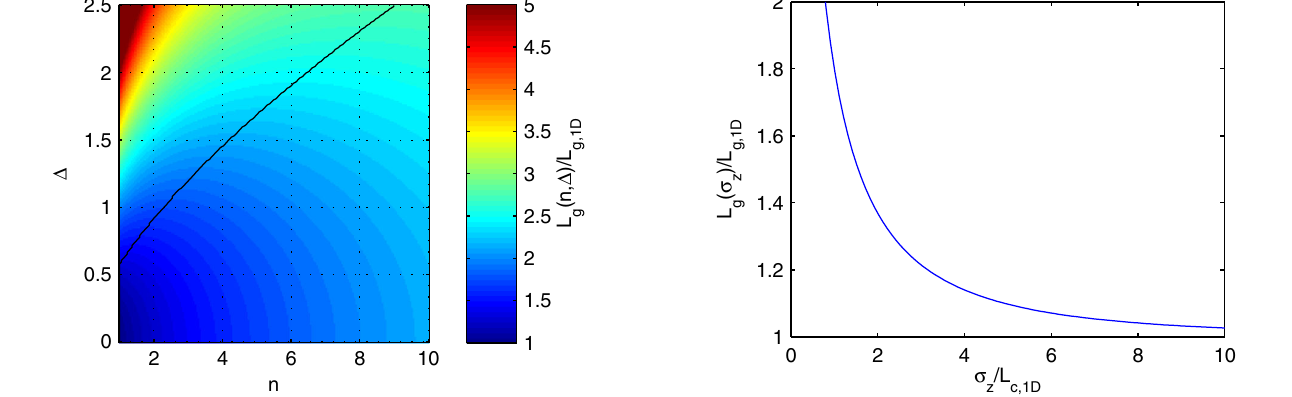
FIG. 3. Normalized gain length L the normalized bunch length (cid:3)